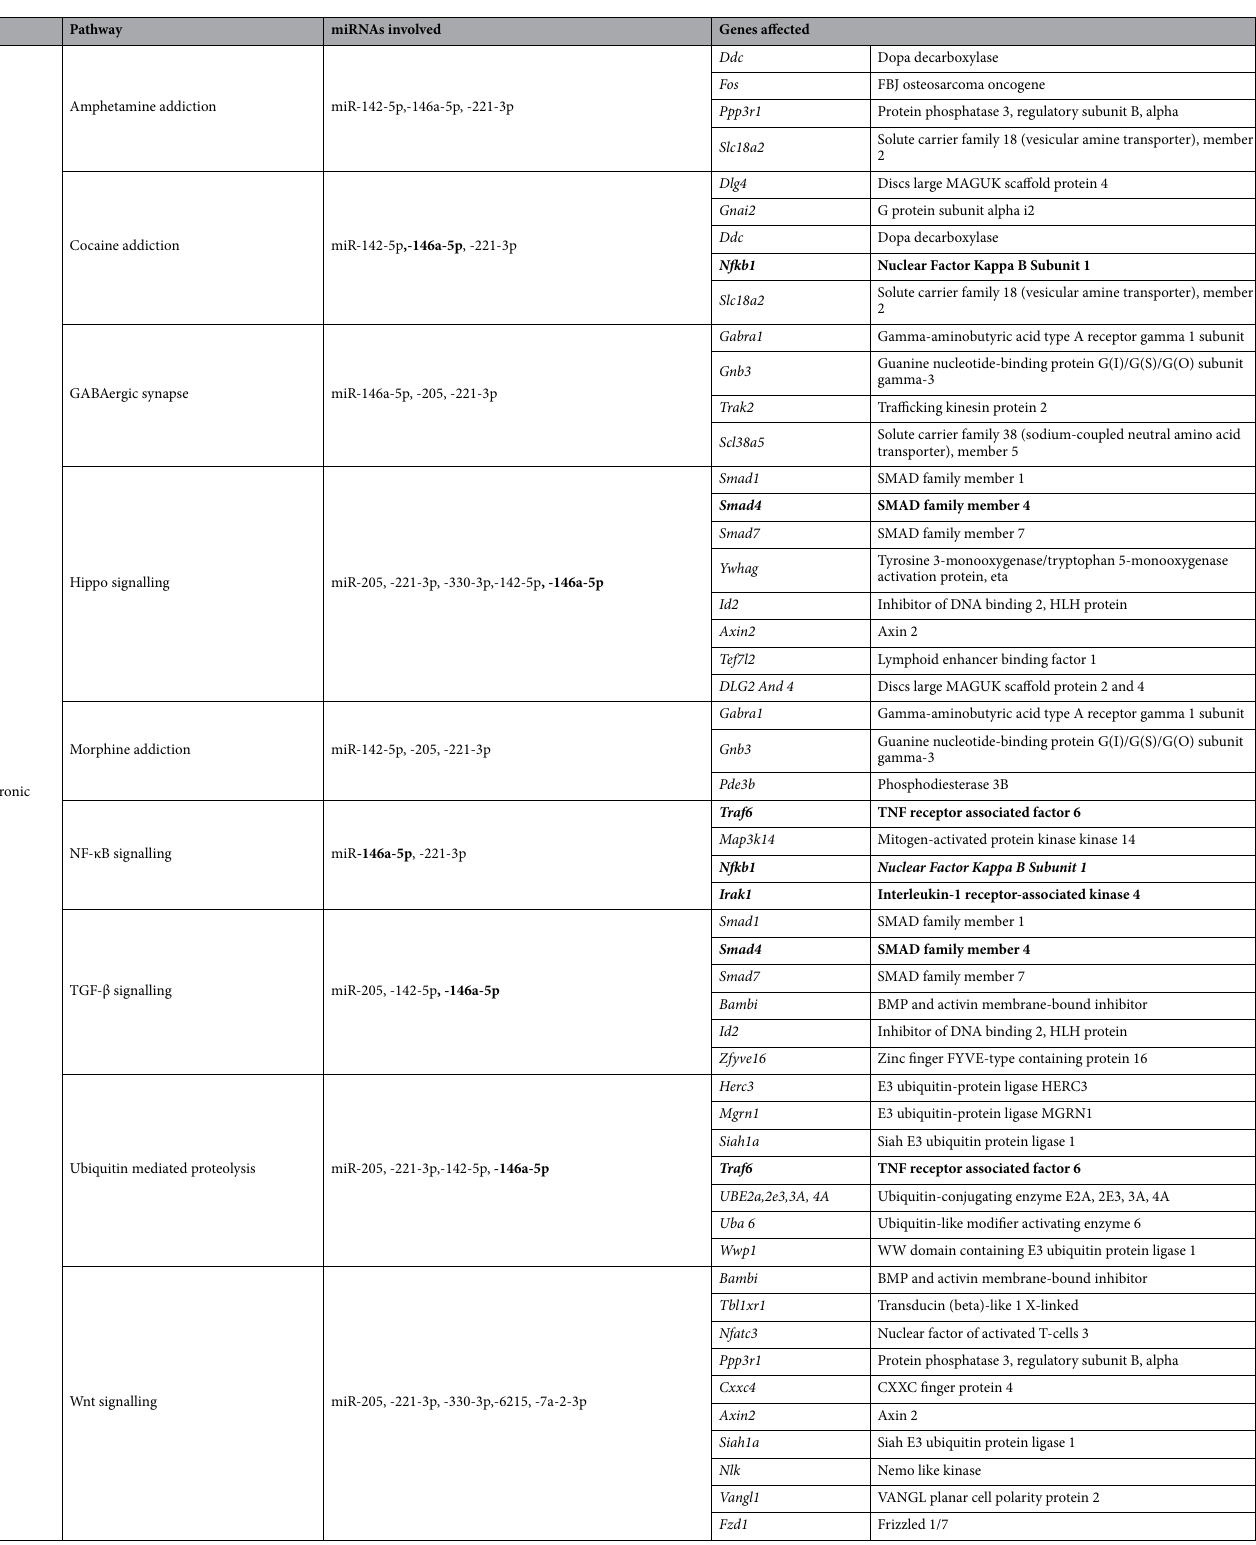
Table 3. Predicted pathways and genes affected by aberrantly expressed miRNAs in TLE with onset in adulthood and infancy. Detailed list of predicted pathways and genes regulated by miRNAs with altered expression across three epilepsy stages in TLE model. DIANA mirPath v3 software generated predicted pathways based on miRNA lists uploaded for each epilepsy stage with both onset groups analysed separately. Bold font marks the miRNAs and their targets validated in rat included in miRTarbase